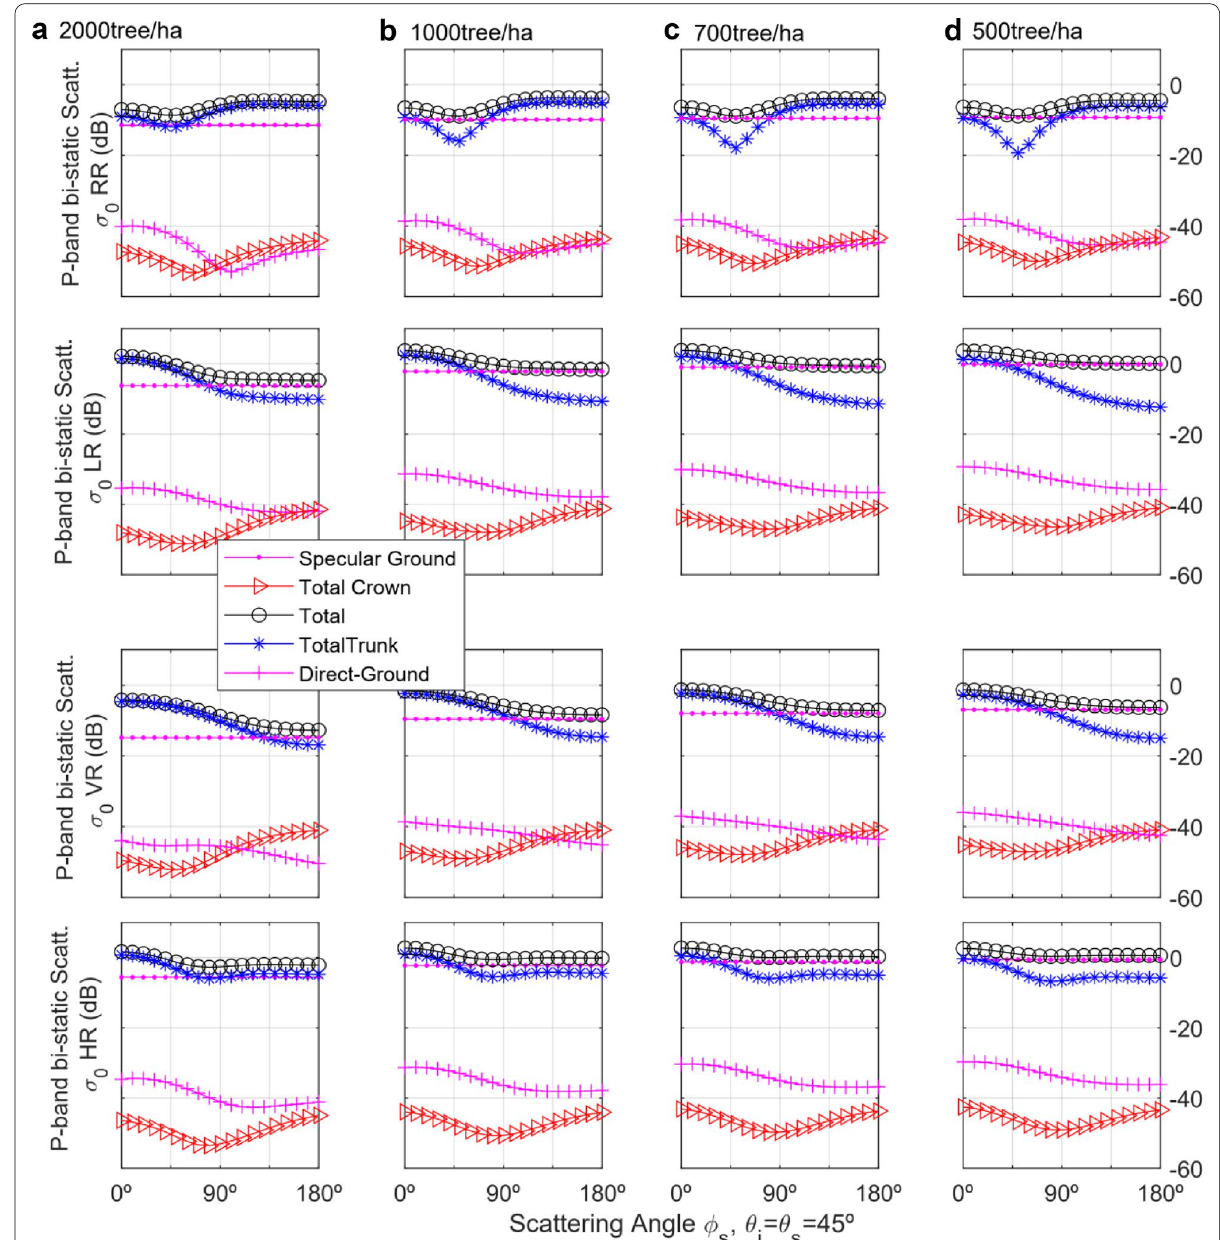
Fig. 13 P-band canopy scattering contributions versus scattering azimuth angles at the different polarizations (rows) for the 4 tree densities (columns). θi θs = =